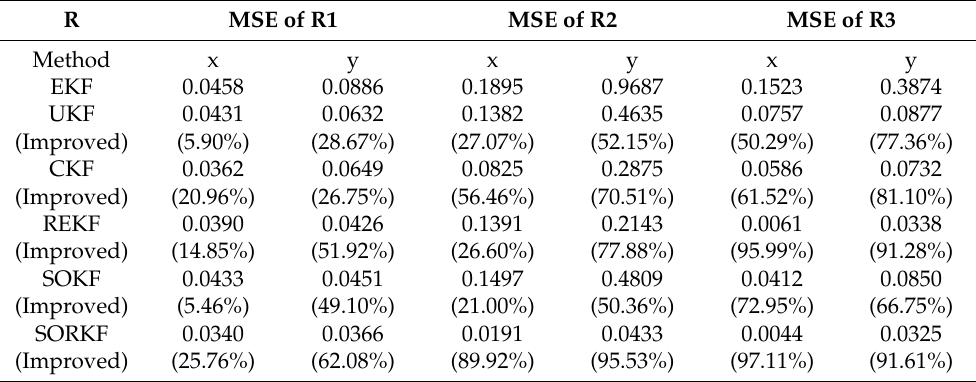
Table 4. MSE for multi-robot trajectory estimation in random topology formation.